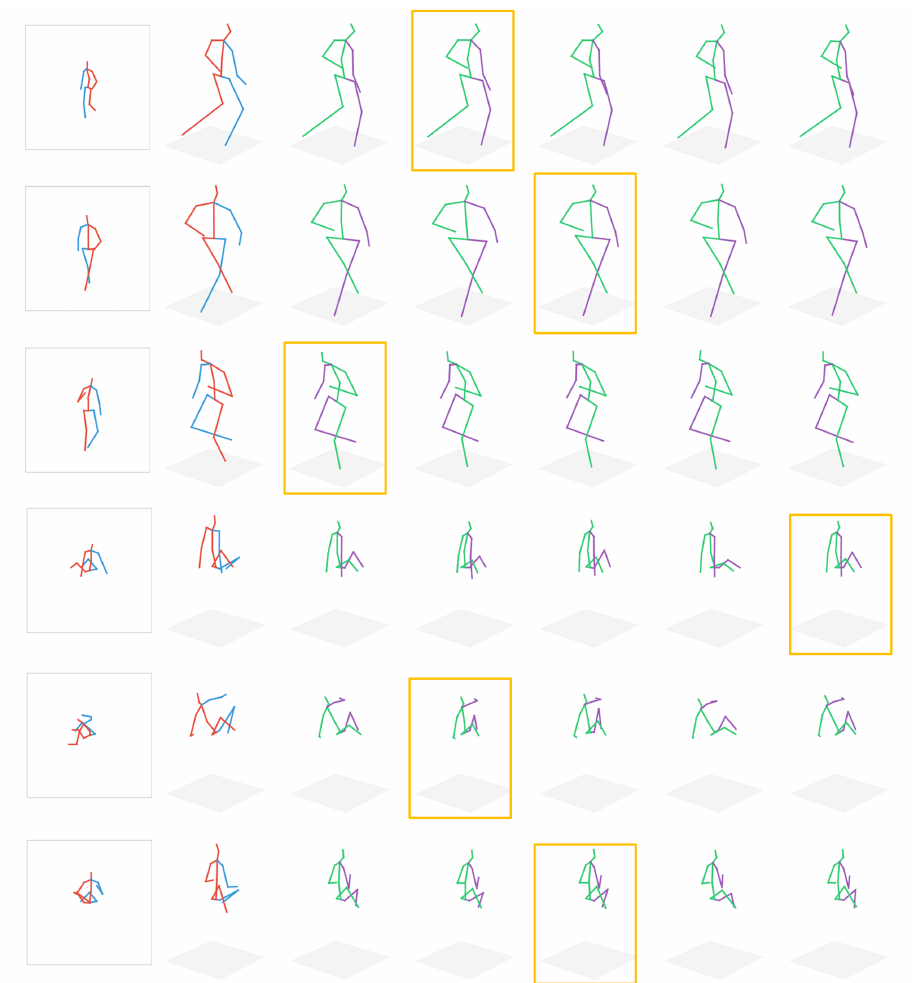
Figure 4. Visualization results on Human3.6M dataset. The first column shows the 2D poses estimated by the stacked hourglass network. The second column shows the ground truth offered by the dataset.